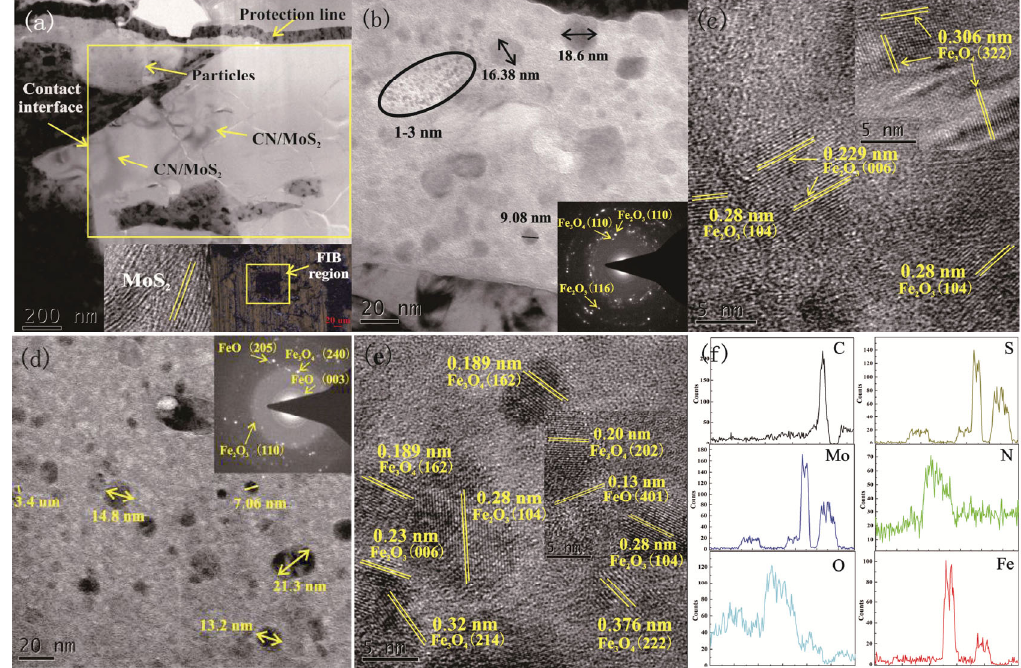
Fig. 7 (a, b, d) TEM images for wear scar cross-section of CN/MoS 2 coating; (c, e) HRTEM of parts in (b, d); (f) line scan mapping of the